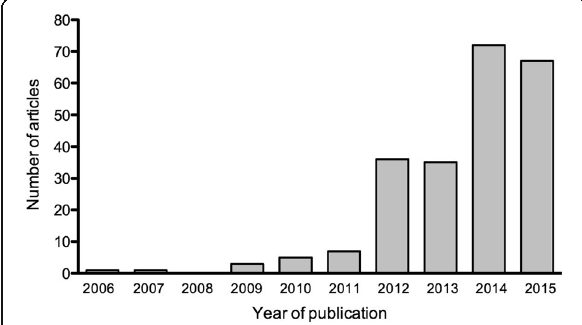
Fig. 1 Numbers of articles related to MATV as a function of the year of publication. Publications were identified using a MEDLINE search with the following enquiry: ( “ MATV ” or “ MTV ” ) and “ PET ” . Only human studies were